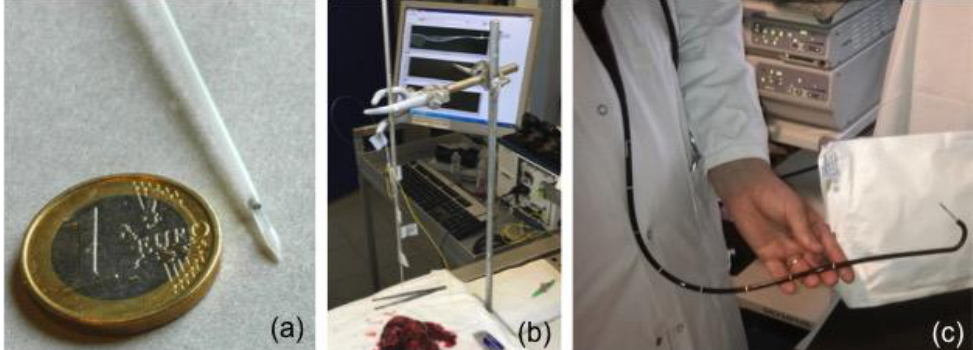
Figure 12. ( a ) Picture of the packaged plasmonic fiber-grating sensor; ( b ) biosensor inserted in a freshly biopsied tissue and its corresponding amplitude spectrum; and ( c ) packaged sensor inserted in the operating channel of an endoscope.